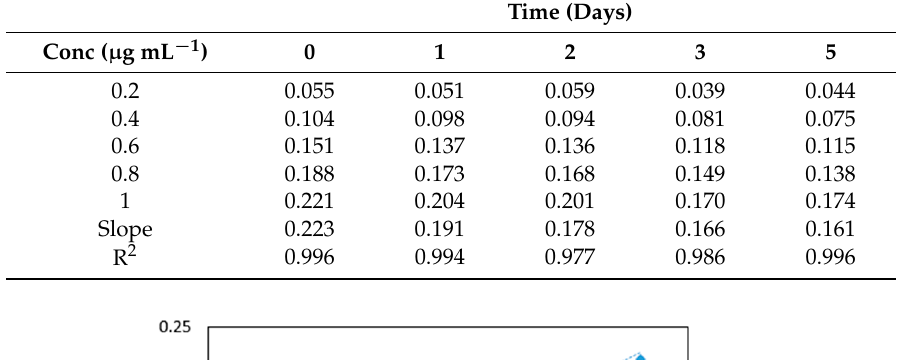
Table 7. Average absorbance for arsenic samples (0.2–1 µ g mL − 1 ) analyzed periodically on day 0, 1, 2, 3, 4 and 5 under the same conditions with the same dye and buffer mix. All measurements were carried out in triplicate ( n = 75).